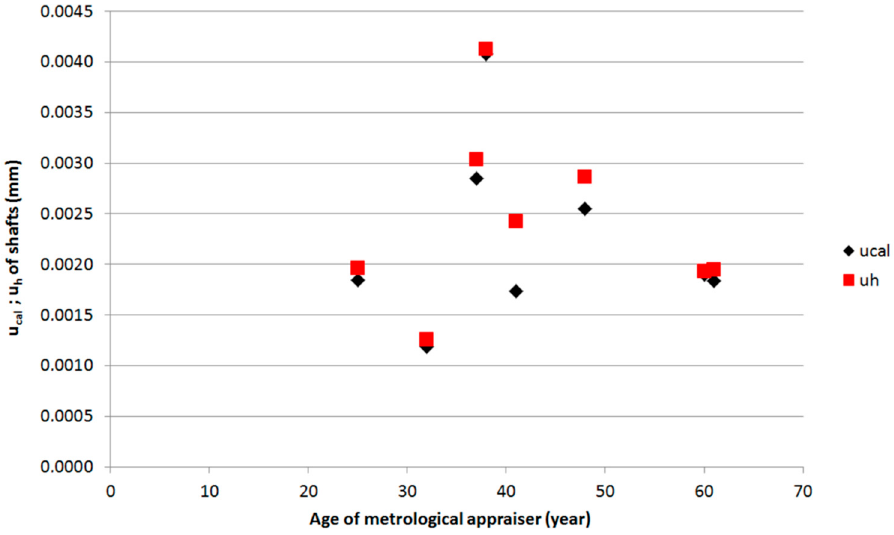
Figure 2. Dependence of calibration uncertainty ( u cal ) and average uncertainty of dimension d 2 ( u h ) on age of metrological